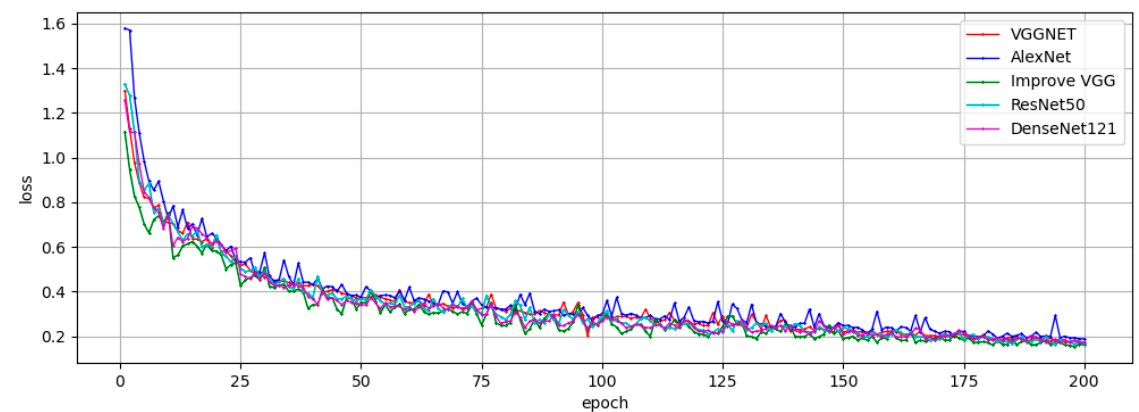
Figure 12. Variation of loss function for different models .